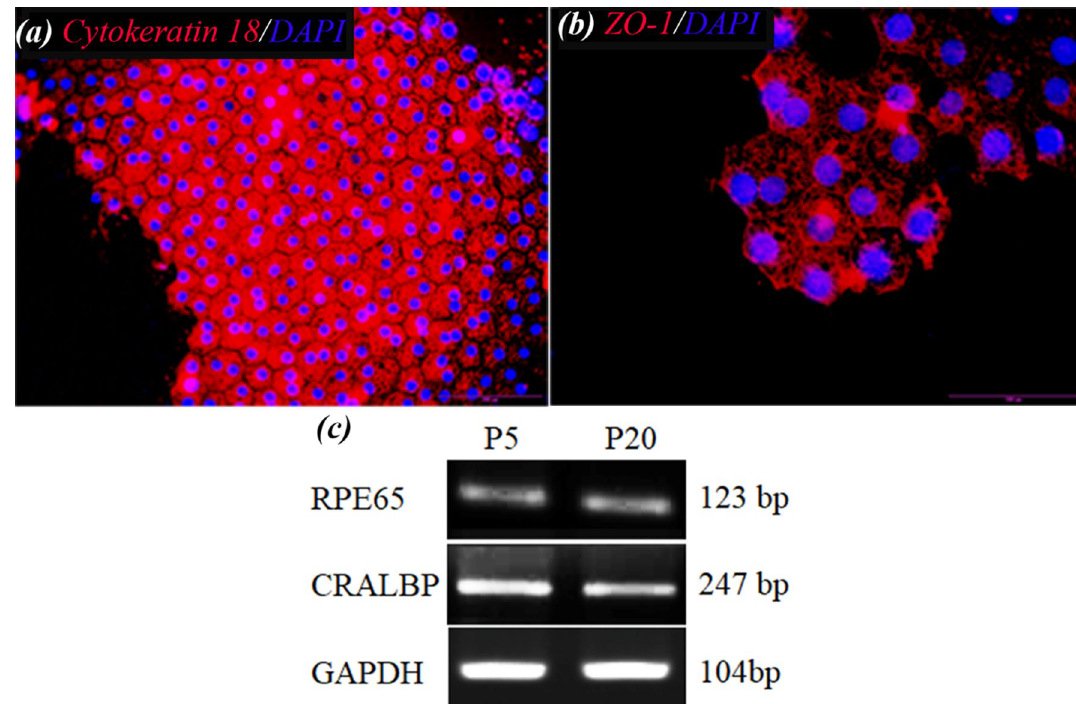
Figure 12. Immunostaining images of ( a ) Cytokeratin 18 and ( b ) ZO-1 of ARPE cells at day 7. These images indicated the monolayer sheet formation by ARPE cells but most of ZO-1 protein was observed in intracellular pools. ( c ) Expression of RPE65, and CRALBP genes in ARPE cells cultured for 7 days and from passage 5 (P5) and passage 20 (P20), detected by RT-PCR (( c ) has been cropped and its original images are shown in the Supplementary Information